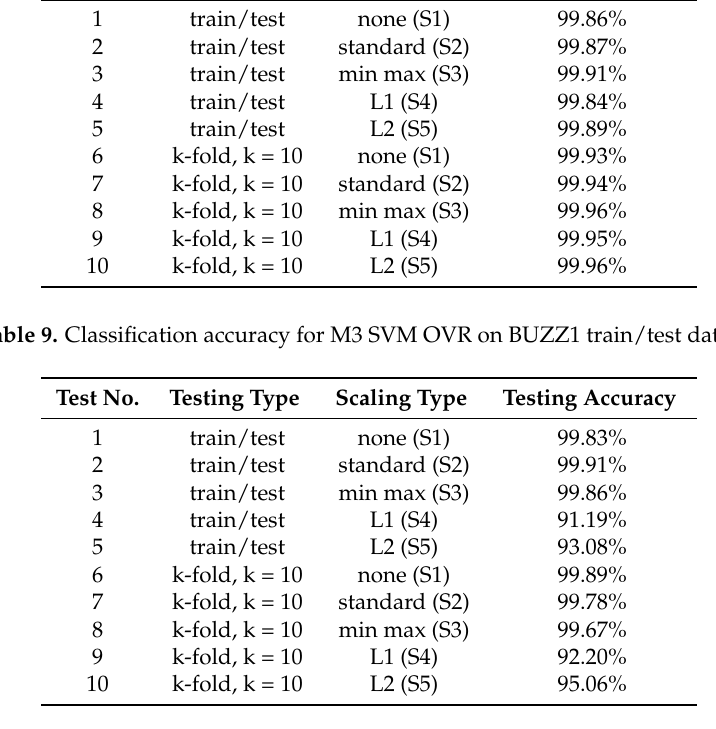
Table 8. Classification accuracy for M2 KNN on BUZZ1 train/test dataset. The accuracy is the mean accuracy computed over n ∈ [ 1,25 ] , where n is the number of nearest neighbors. Test No.